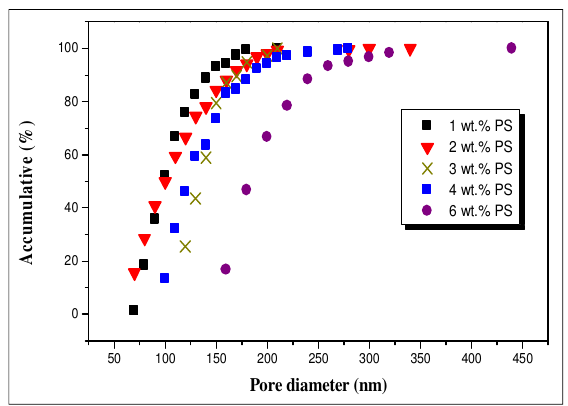
Fig. 9. Effect of mean roughness of the outer surface of hollow fiber membranes on the pure water permeability